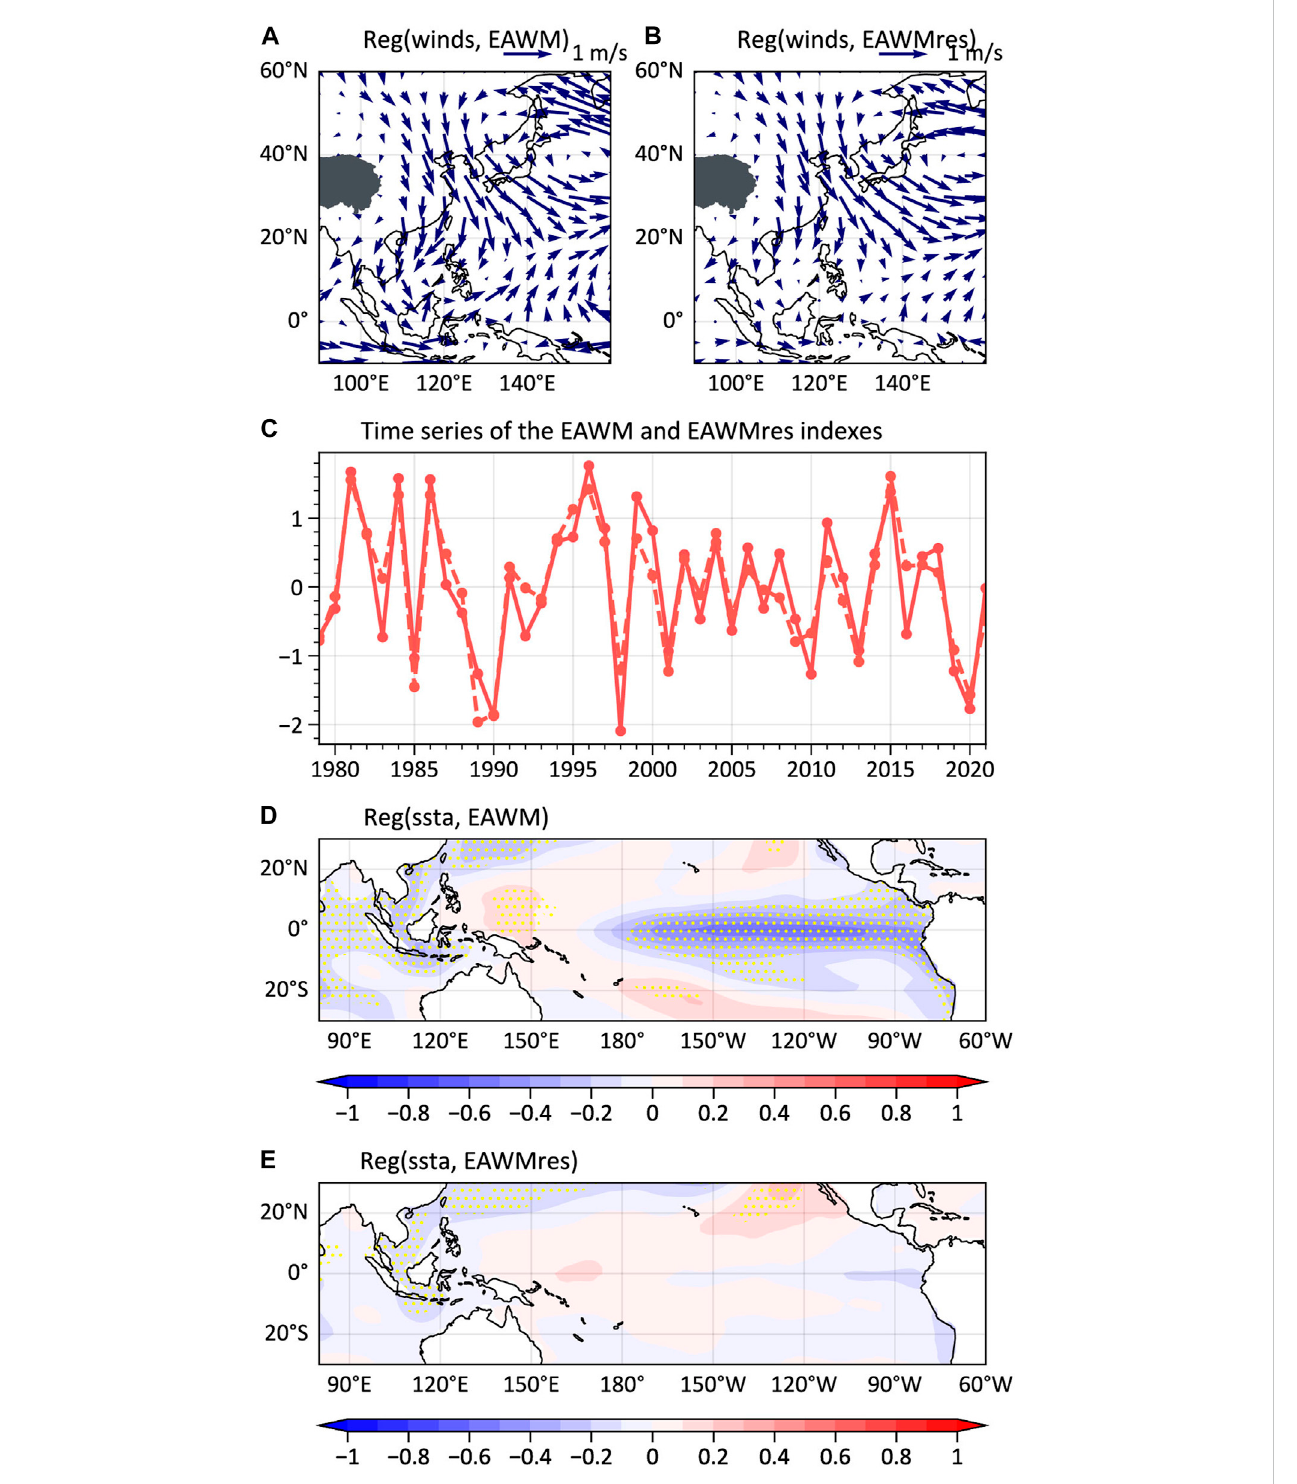
Regression patterns of anomalous winds at 850 hPa onto the (A, B) EAWM index and the EAWM res index, respectively. (C) Time series of the EAWM and EAWM res indexes. (D, E) Regression patterns of anomalous SST onto the EAWM and EAWM res indexes, respectively. Dotting in (D, E) indicates anomalies that exceed the 95% con fi dence level. Details for de fi nitions of the EAWM and the EAWM res indexes can be found in (Chen et al., 2013a; Ma et al., 2018b). The NCEP2 reanalysis and the ERSSTv5 dataset for the period 1979 – 2021 are used in this fi